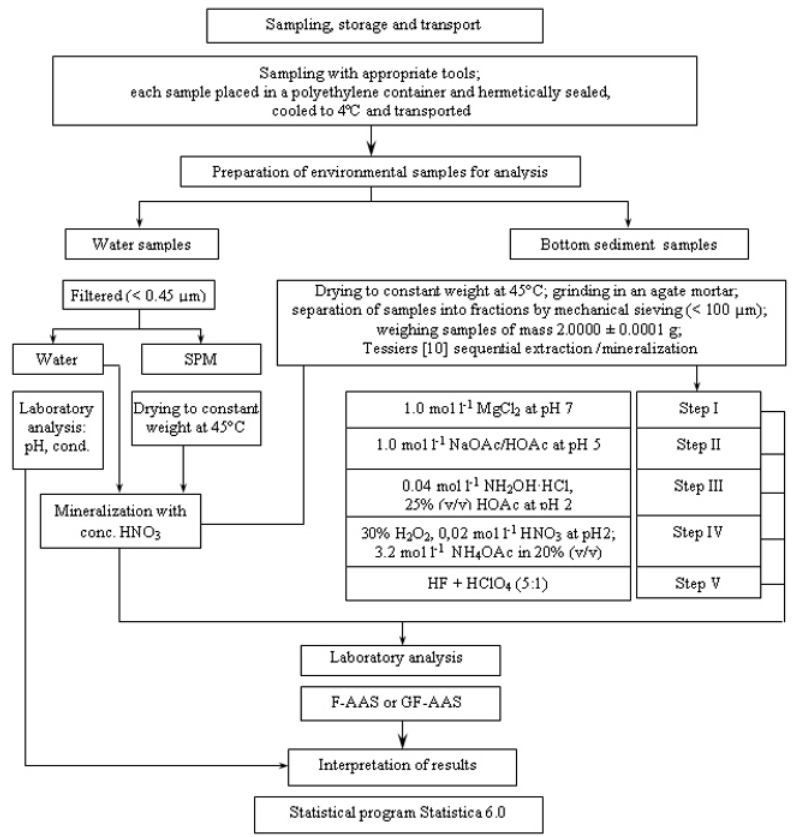
Figure 2. The procedure for environmental